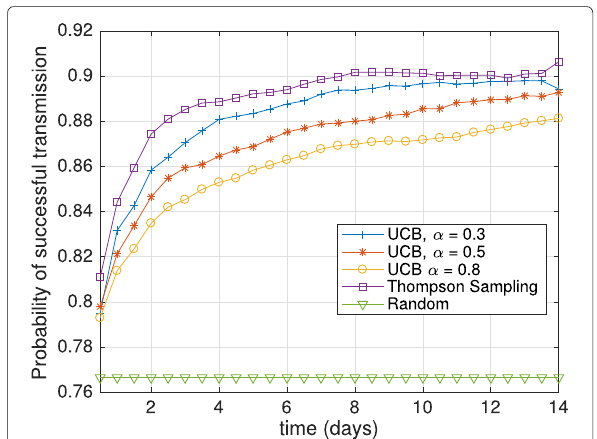
Fig. 13 Evolution of the number of successful transmissions with time for different learning schemes